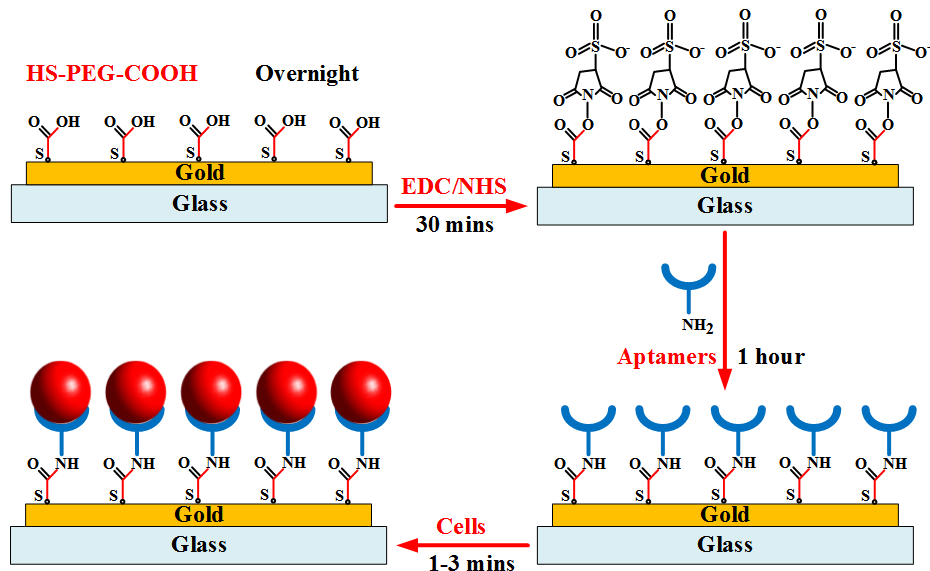
Figure 3. Illustration of aptamer immobilization procedure onto gold substrate for binding of target